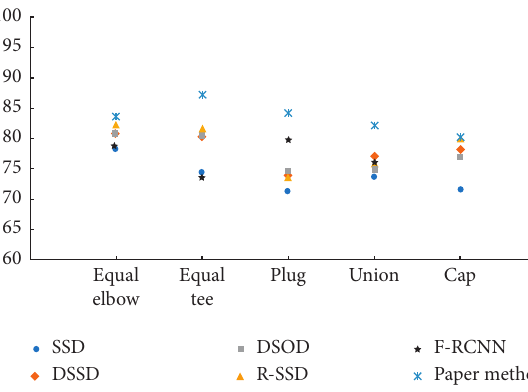
Figure 8: Comparison of recognition accuracy of different target detection